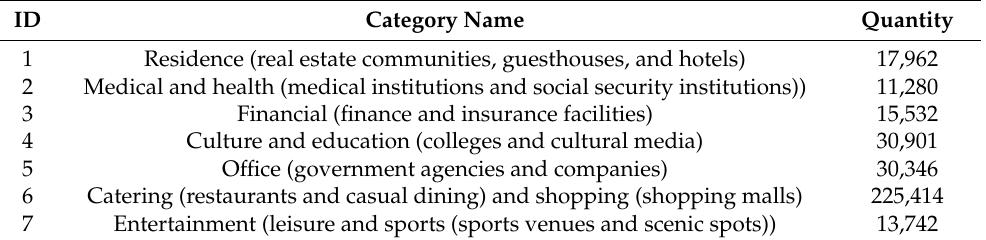
Table 6. POI categories.